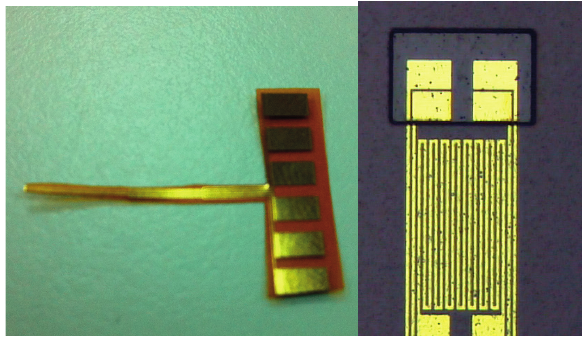
Figure 3. Finished product and optical micrograph of the flexible three-in-one microsensor.